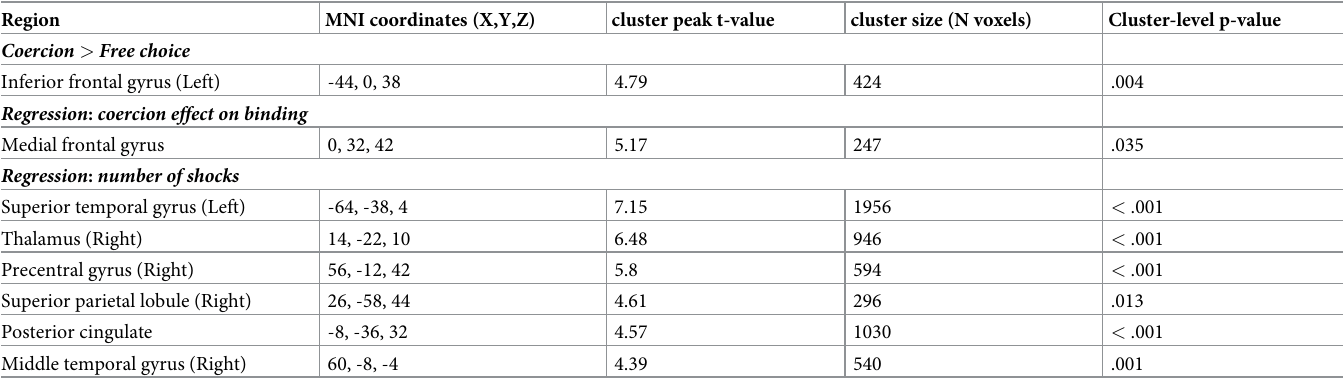
Table 2. Whole-brain fMRI analyses